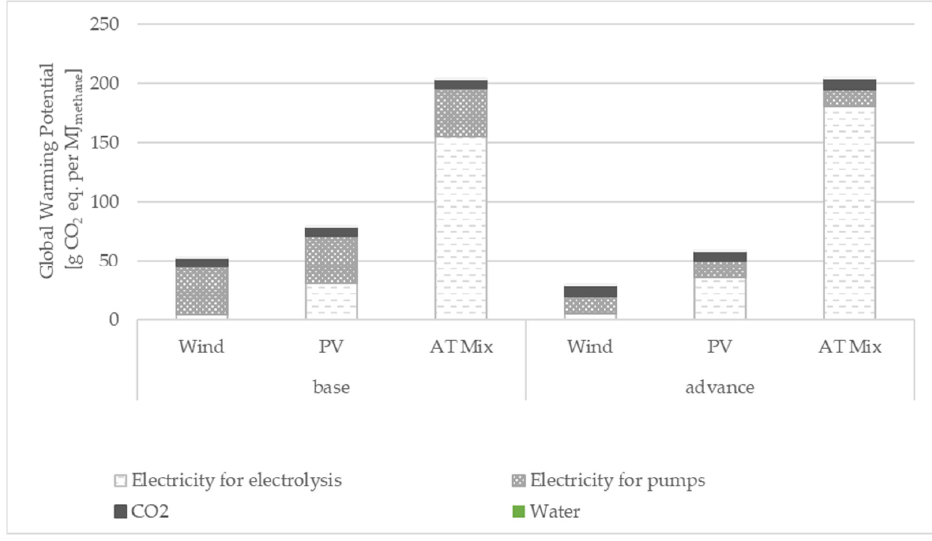
Figure 15. Global Warming Potential (GWP) for USC Scenarios (source: authors own based on GaBi ts 10 and ecoinvent v3.6).